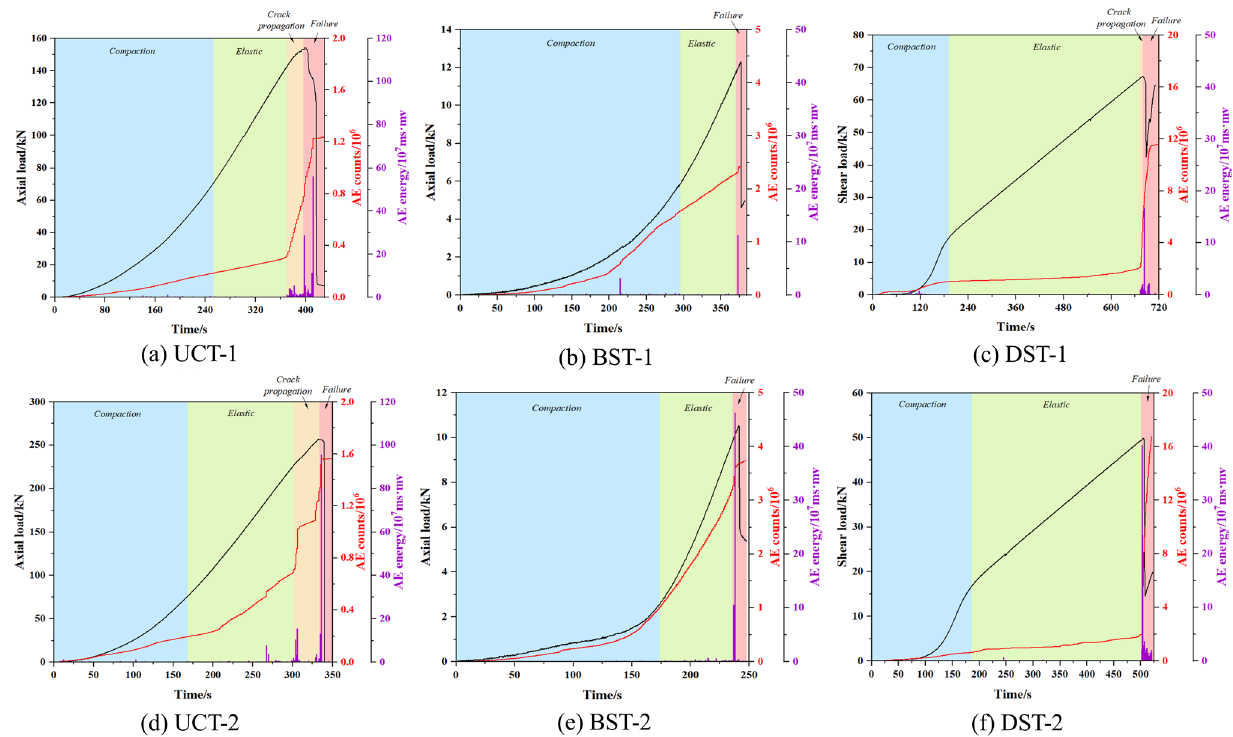
Fig. 3 Load and AE time-history curves of samples: a UCT-1; b BST-1; c DST-1; d UCT-2; e BST-2; f